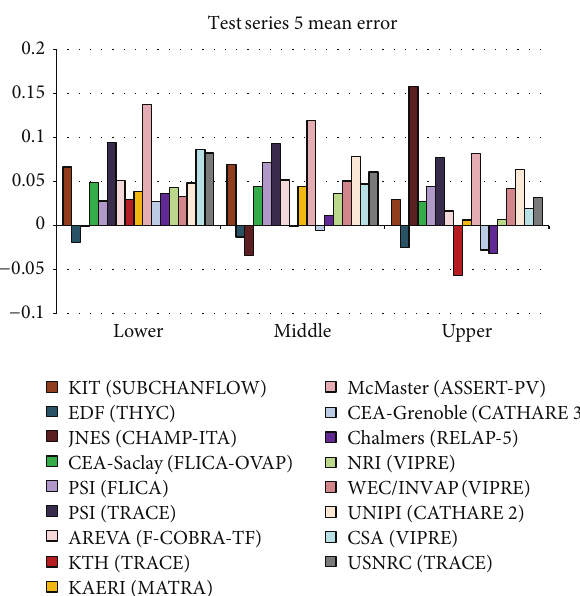
Figure 25: Test series 6 void fraction mean error.